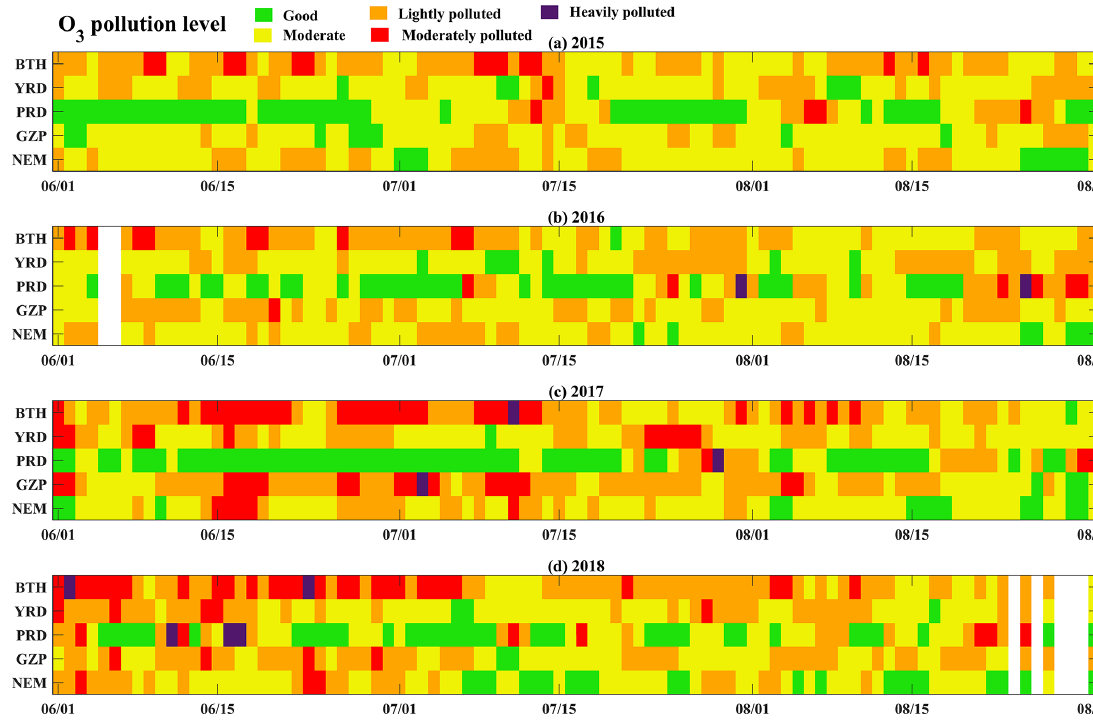
Figure 2. Time series of MDA8 O 3 pollution levels in key urban clusters.